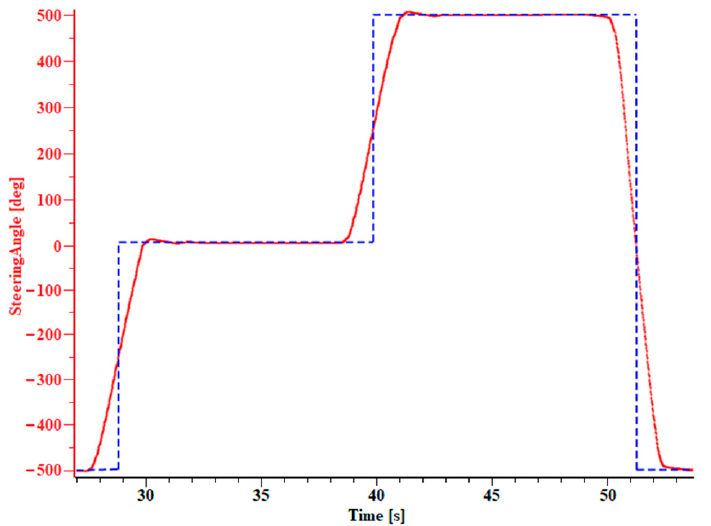
Figure 7. Steering Wheel Angle Change.